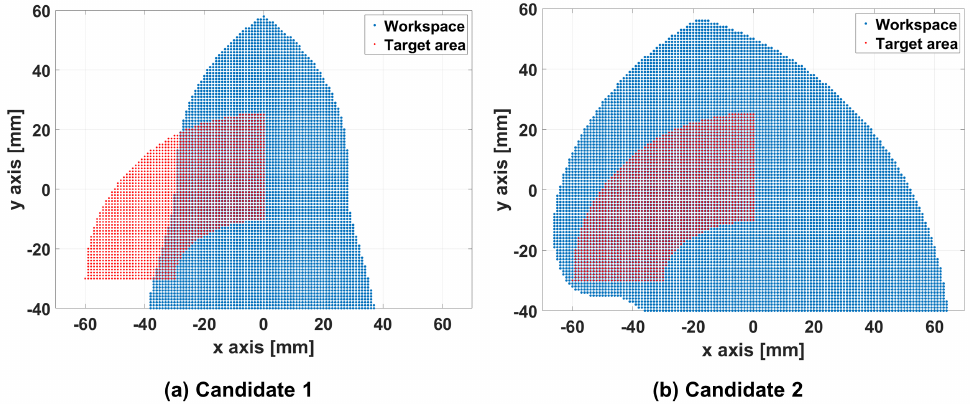
Figure 12. The workspace when the target workspace overlapped in same coordinate space: ( a ) Candidate 1, ( b ) Candidate